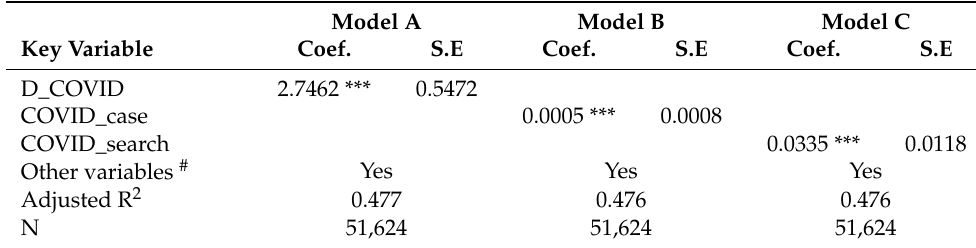
Table 6. Estimation of the government payments